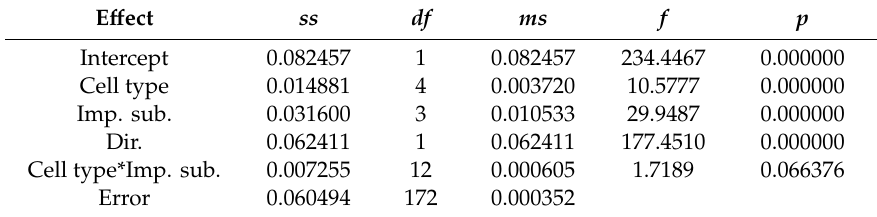
Table 5. Univariate Tests of Significance–ANOVA.